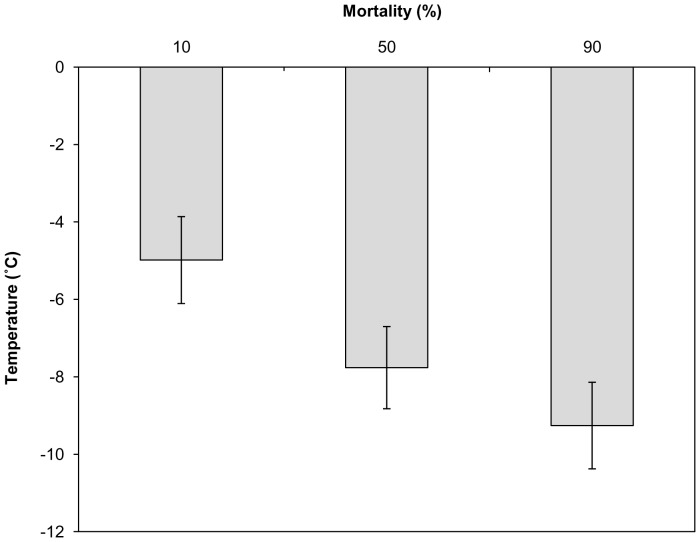
Lower Lethal Temperatures of worker bumblebees (Bombus terrestris audax).The LLTemp10,50 and LLTemp90 (±SE) of worker bumblebees as determined by Probit analysis, n = 30 per temperature.